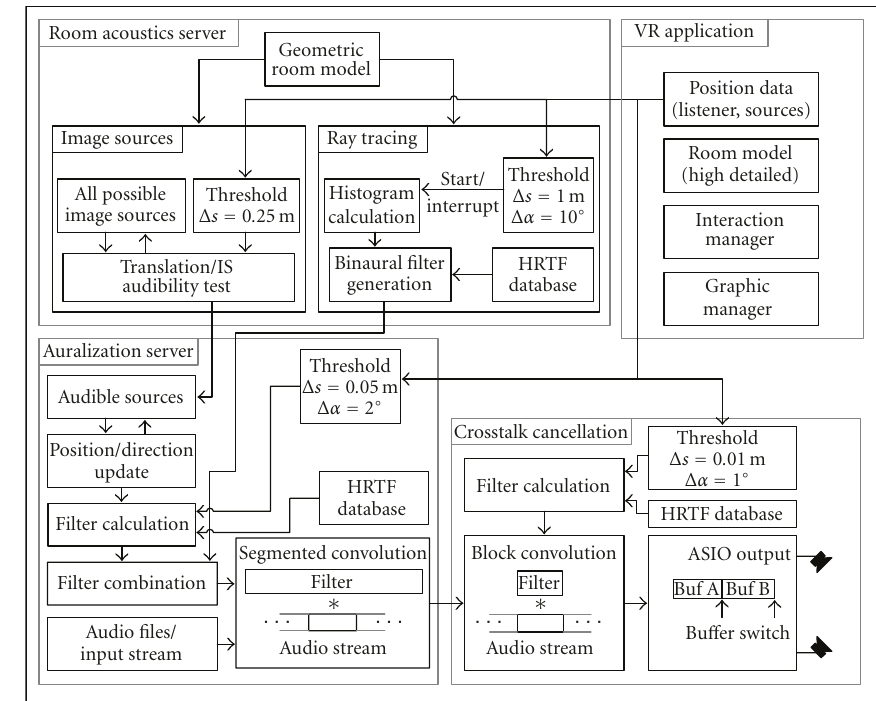
Figure 10: The complete binaural auralization system.